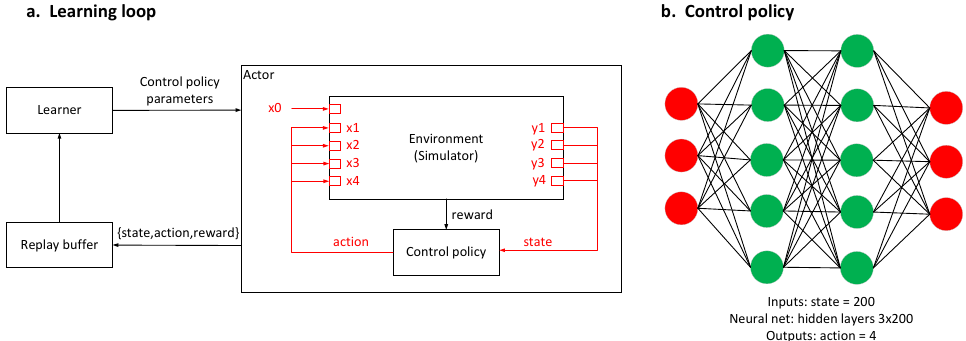
Figure 3. The RL algorithm and control policy. ( a ) Depiction of the learning loop. The controller sends force commands on the basis of the acceleration state and control targets. ( b ) The control policy is a feed-forward neural network, with three hidden layers, which takes measurements and outputs force commands.